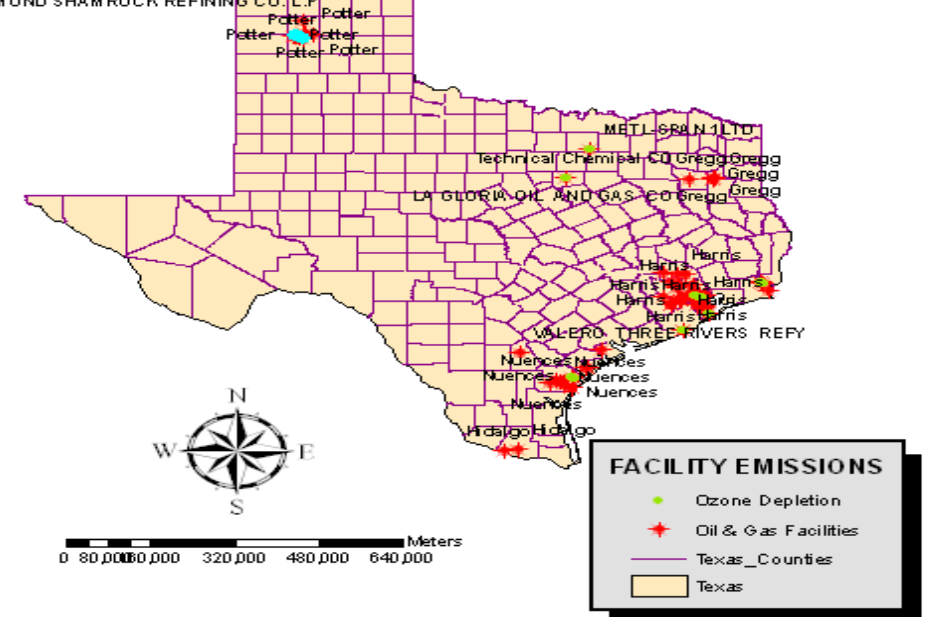
Figure 9. Spatial Concentration of Facilities Emitting Cancer Causing Substances of